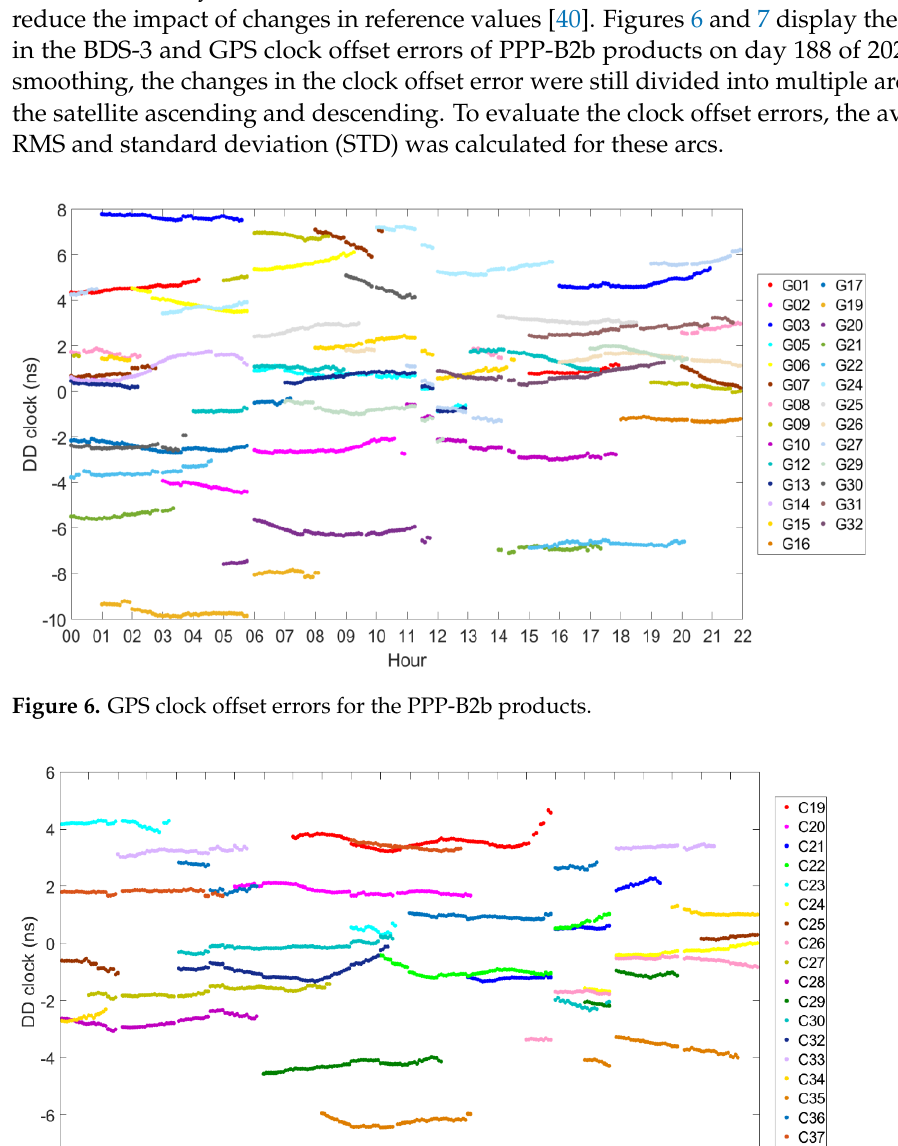
Figure 5. RMS values of BDS-3 orbit errors for the PPP-B2b products.